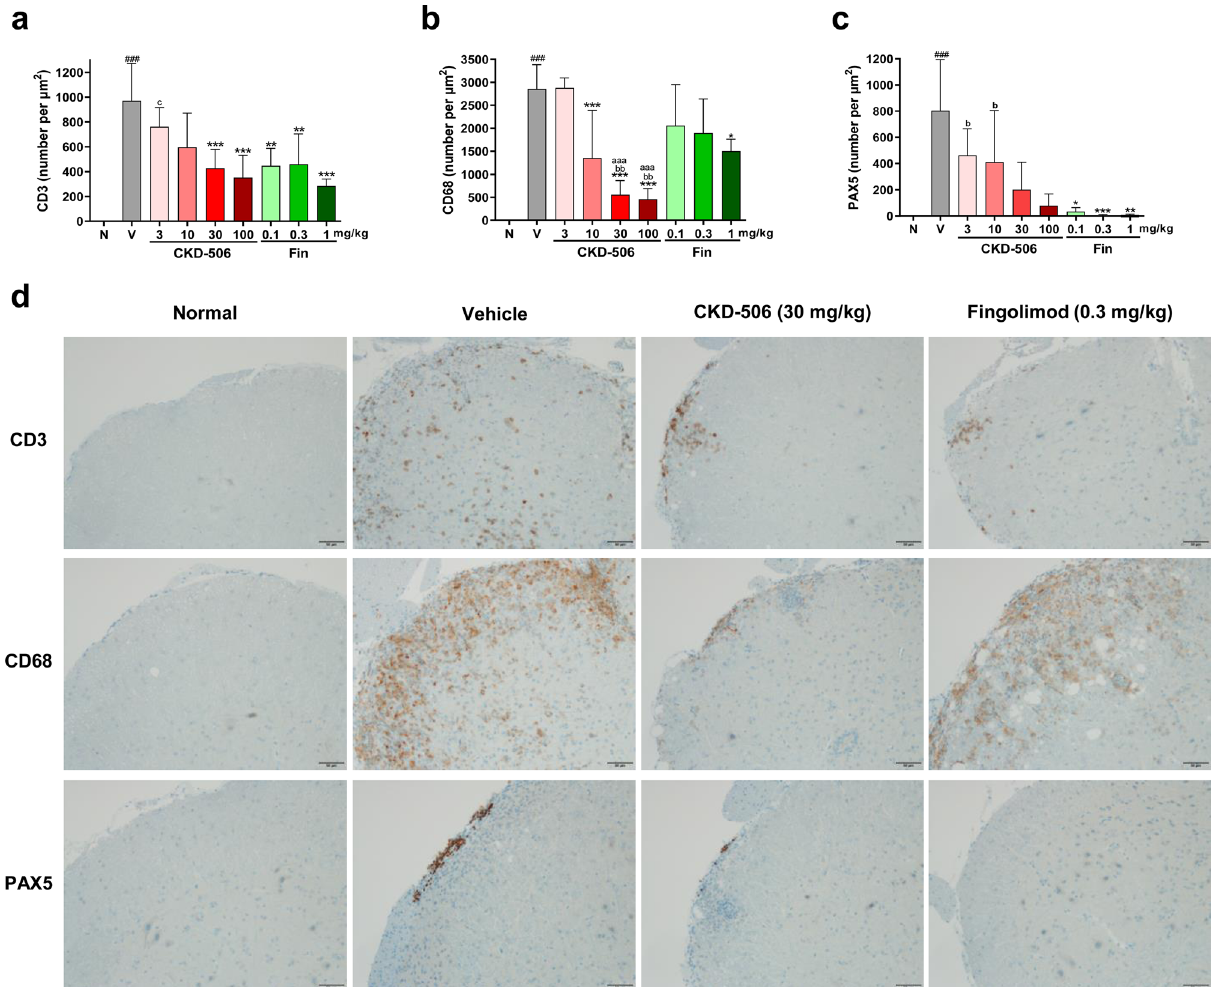
Figure 2. CKD-506 decreased the infiltration of CD3 + T cells and CD68 + microglia/macrophages into the spinal cord parenchymal region in the experimental autoimmune encephalitis (EAE) mouse model on day 29 post-EAE induction. C57BL/6 mice [n = 6 per group for the fingolimod (1 mg/kg)-treated group; n = 7 per group for the non-immunized groups, CKD-506 (3, 10 mg/kg)-treated groups, and fingolimod (0.1 mg/kg)- treated group; n = 8 per group for the other groups] were orally administered CKD-506 (10, 30, or 100 mg/kg) or fingolimod (0.1 or 0.3 mg/kg) daily from day 6 post-myelin oligodendrocyte glycoprotein 35–55 immunization ( a – d ). The number of CD3 + T cells ( a ), CD68 + microglia/macrophages ( b ), and PAX5-positive B cells ( c ) in the spinal cord were analyzed. ( d ) Representative images of immunohistochemical analysis are shown. Data are presented as mean ± SD; one-way ANOVA, followed by multiple comparisons post-hoc test with Tukey’s test for ( a , b ); Kruskal–Wallis test, followed by multiple comparisons post-hoc test with Dunnett’s test for ( c ). ### p < 0.001, non-immunized groups versus vehicle group; * p < 0.05, ** p < 0.01, and *** p < 0.001, drug-treated group versus vehicle group; aaap < 0.001, CKD-506-treated group versus fingolimod (0.1 mg/kg)-treated group; bp < 0.05, bbp < 0.01, CKD-506-treated group versus fingolimod (0.3 mg/kg)-treated group; cp < 0.05, CKD- 506-treated group versus fingolimod (1 mg/kg)-treated group. N, non-immunized groups; V, vehicle group; Fin, fingolimod-treated CKD‑506 enhanced blood–brain barrier (BBB) integrity in mice with EAE. strated that the maintenance of BBB integrity can prevent the induction and exacerbation of symptoms in mice with EAE 23 . This study examined the extravasation of the Evans blue (EB) dye and the expression level of occlu- din, an endothelial tight junction protein, in the spinal cord to determine the effect of CKD-506 and fingoli- mod on BBB integrity in the vehicle group on day 21 post-EAE induction. Additionally, the levels of acetylated α-tubulin in the spinal cord were also examined to confirm the passage of CKD-506 through the BBB to exert its effect on the CNS. EB leakage was detected in the spinal cord of the vehicle group but not in the non-immu- nized groups, while the EB volume in the spinal cord of the CKD-506 (30 and 100 mg/kg bodyweight)-treated group was significantly lower than that in the spinal cord of the vehicle-treated group [Fig. 5a; F(5, 43) = 4.122; p = 0.0038; one-way ANOVA]. However, the EB volume in the spinal cord did not significantly differ between